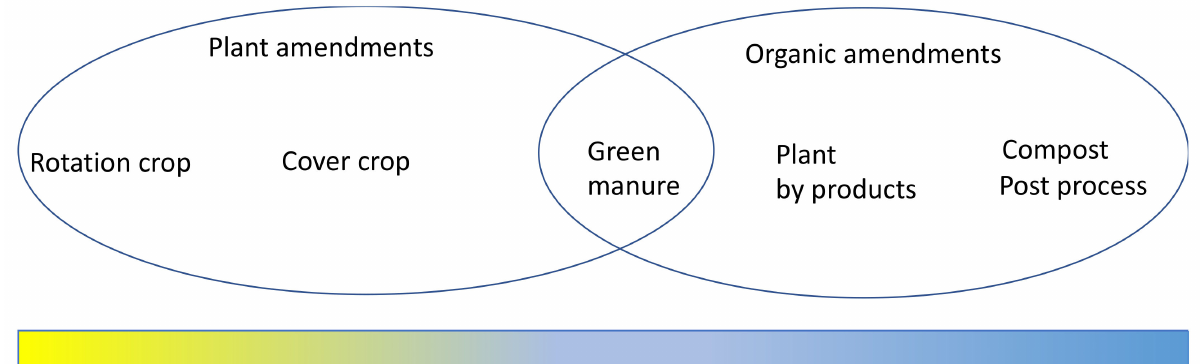
Figure 2. Schematic diagram of plant-based materials used as soil amendments and their stages in plant cycle. The bar on the bottom shows plant stages, changing from living plants (yellow) changing to decomposed compounds